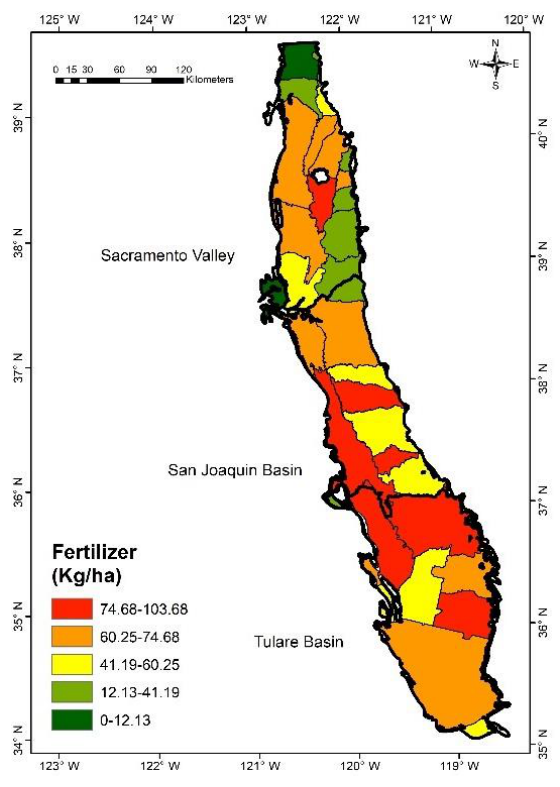
Figure 13. Fertilizer loading in Central Valley